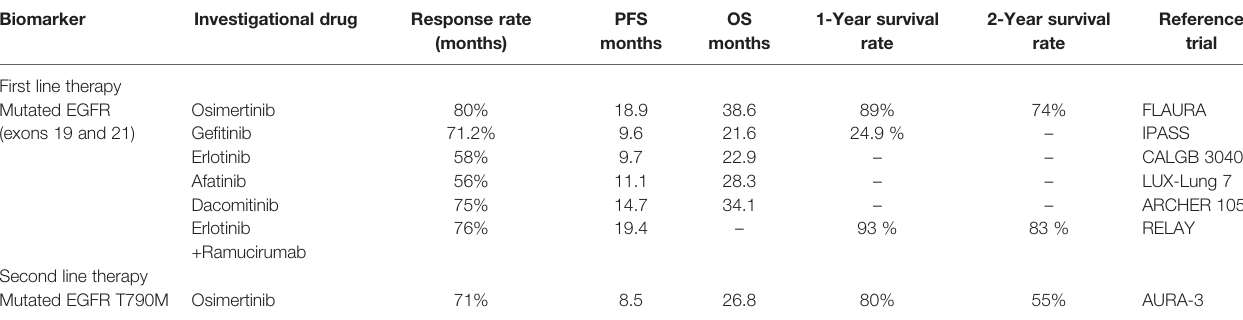
TABLE 1 | Therapeutics options for patients with actionable mutations of the EGFR, regardless histology.